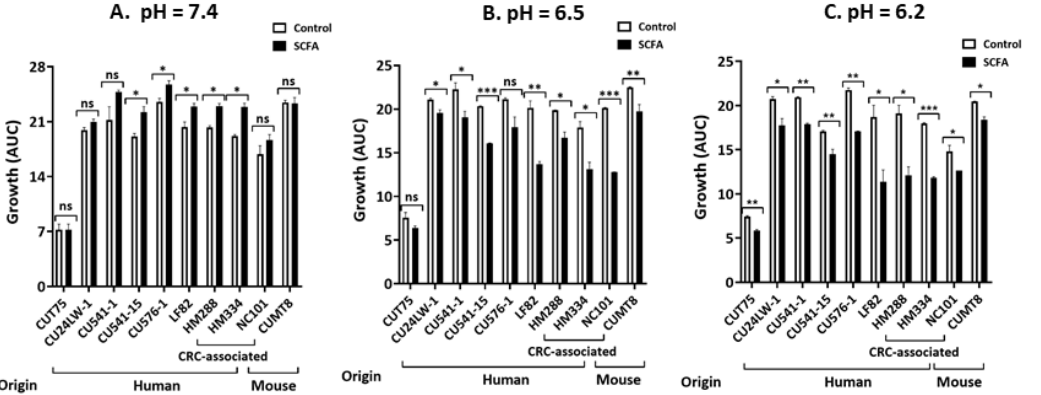
Figure 3. Inhibition of E. coli growth by colonic SCFA is pH dependent. LB broth was adjusted to pH = 7.4, 6.5 or 6.2 with HEPES (pH = 7.4), MOPS (pH = 6.5) or PIPES (pH = 6.2). The growth conditions were the same as described in Figure 1. Data from 3 independent experiments; Mean ± SE. * p < 0.05; ** p < 0.01; *** p < 0.001; ns = not significant.